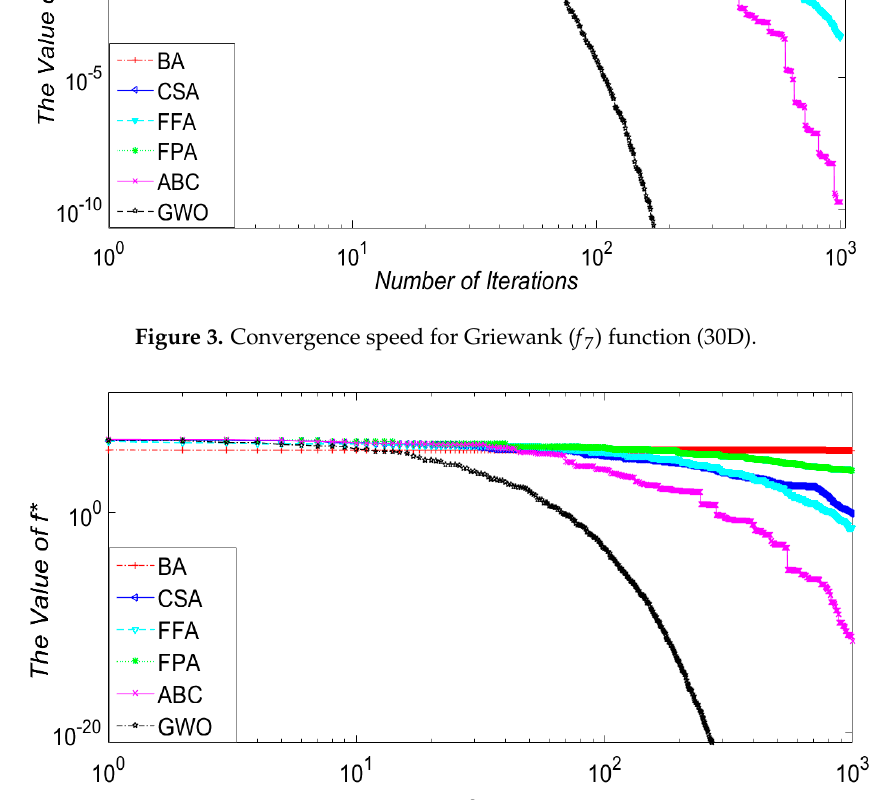
Figure 4. Convergence speed for Cigar ( f 14 ) function (25D).